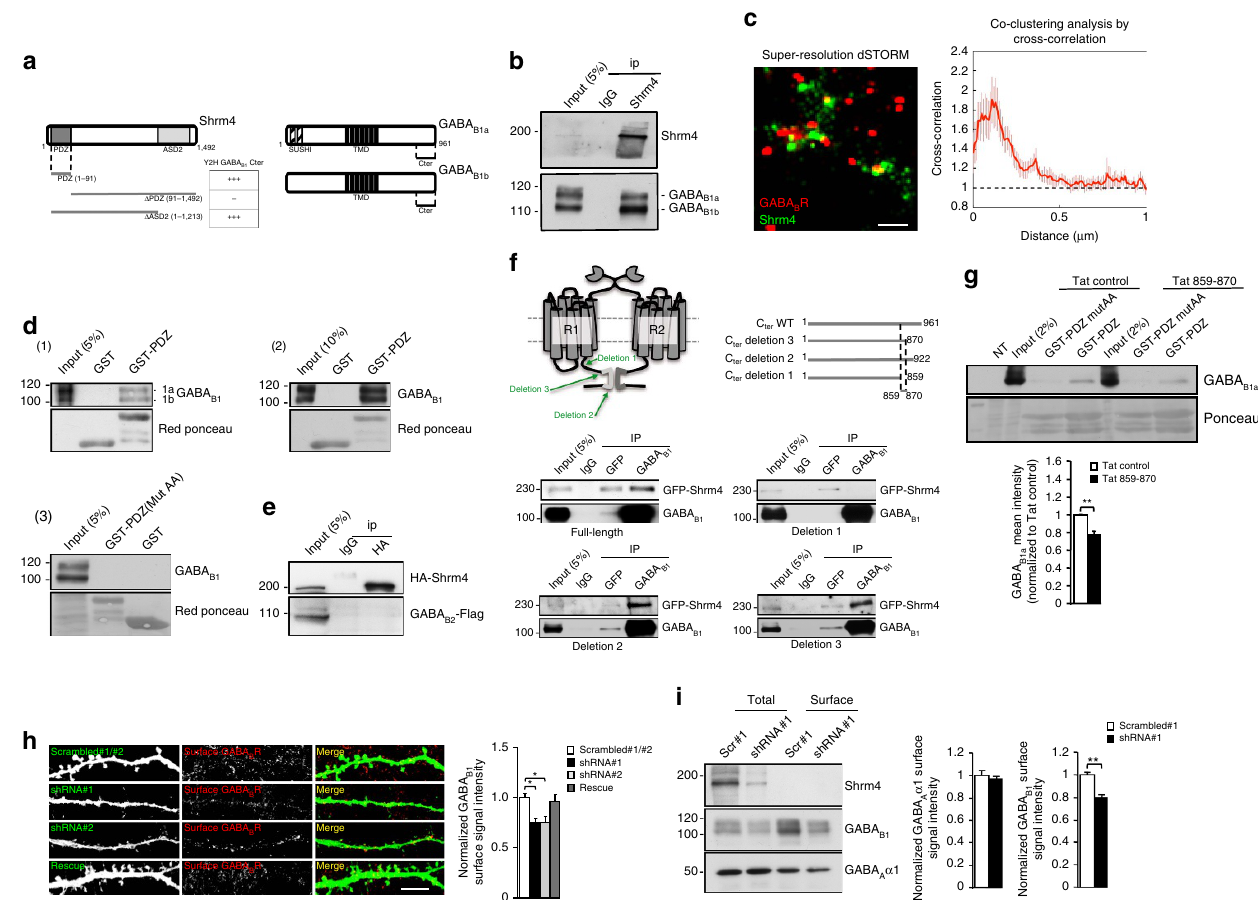
Figure 1 | Shrm4 interaction with GABA B Rs modulates cell surface expression. ( a ) Representations of Shrm4 and GABA B R subunit 1a and 1b interacting domains. The PDZ domain of Shrm4 (1–91 aa) was used as bait for Y2H screening on adult human brain cDNA library. Twenty positive clones were isolated; six encoded for a 100 aa stretch of the GABA B R subunit 1 C-terminal tail (both isoforms (1a and 1b)). The PDZ domain and D ASD2 constructs interact with the C-terminal tail of GABA B1 ( þ þ þ ) while D PDZ truncated construct does not ( (cid:2) ). TMD: Transmembrane domains. ( b ) Co-immunoprecipitation experiments on adult rat brain extracts using anti-Shrm4 antibody show Shrm4 and GABA B1 association (full blot in Supplementary Fig. 11). ( c ) (Left) dSTORM imaging of GABA B R (red) and Shrm4 (green) on 14DIV rat cultured hippocampal neurons. (Right) Shrm4 and GABA B R puncta co-cluster as evidenced by cross-correlation analysis. Error-bars are s.e.m.; number of regions ¼ 29, number of fields ¼ 3. Scale bar, 0.4 m m. ( d ) GST pull-down experiments on 18 DIV rat cultured hippocampal neurons (1) and rat brain (2) extract show that Shrm4-PDZ domain (GST-PDZ; aas 1–91) pulls down both GABA B1 isoforms whereas (3) mutant GST-PDZ (AA) does not (full blot in Supplementary Fig. 11). ( e ) Co-immunoprecipitation experiments on HEK293 cells expressing HA-Shrm4 and GABA B2 -Flag, showing that Shrm4 does not associate with GABA B2 in absence of GABA B1 (full blot in Supplementary Fig. 11). ( f ) Scheme of truncated GABA B R constructs: deletion 1: D 859–961; deletion 2: D 922–961; and deletion 3: D 870–961 with co-immunoprecipitation results from HEK293 cells expressing Shrm4-GFP and each of the GABA B1a constructs. GFP-Shrm4 immunoprecipitates full-length GABA B1a , deletion 2, and deletion 3, but not deletion 1 (full blot in Supplementary Fig. 11). ( g ) (Top) GSTpull-down experiments using GST-PDZ or mutant GST-PDZ (AA) on lysates of HEK293 cells overexpressing GABA B1 and GABA B2 incubated with Tat-control peptide or Tat-859–870 peptide corresponding to the previously identified minimal GABA B1 -Shrm4 binding region. (Bottom) Histograms showing GABA B1a mean intensity normalized to Tat-control peptide ± s.e.m. n ¼ 3; ** P ¼ 0.046; t -test (full blot in Supplementary Fig. 11). ( h ) Surface immunostaining for GABA B R in rat cultured hippocampal neurons at 18 DIV transfected with scrambled, shRNA#1, shRNA#2 or rescue constructs at 8 DIV . Scale bar, 15 m m. Histograms show mean ± s.e.m. n ¼ 5–15, Scrambled versus shRNA#1 * P ¼ 0.0153; Scrambled versus shRNA#2 * P ¼ 0.0153; One-way ANOVA-Mann–Whitney. ( i ) GABA B R cell surface biotinylation from 18 DIV rat cultured hippocampal neurons infected with scrambled#1 (Scr#1) or shRNA#1 (shRNA#1) at 8 DIV and western blot. Shrm4 silencing reduces GABA B1 surface expression, but does not change total signal for GABA B1 or surface (and total) signal for GABA A R a 1 subunit. Histograms show mean ± s.e.m.; n ¼ 4; ** P ¼ 0.0069; t -test (full blot in Supplementary Fig.